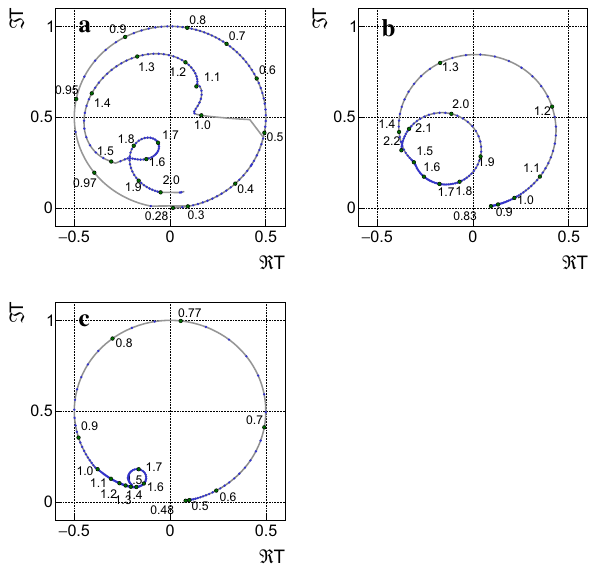
Fig. 12 Argand plots for the projection ππ → ππ of the waves S 0 ( a ), D 0 ( b ), P 1 ( c ). The numbers along the lines denote the masses at these positions. Exemplarily, the results using the scattering data for the solution ( − − − ) from [21] for the S0-wave and from [21] [22] for D0- and P1-wave the are shown